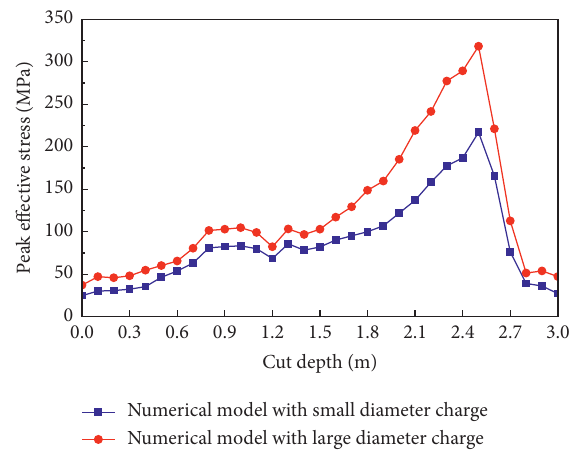
Figure 7: Peak effective stress with cut depth along a central measuring Table 7: Blasting parameters for cut blasting with a small diameter charge.